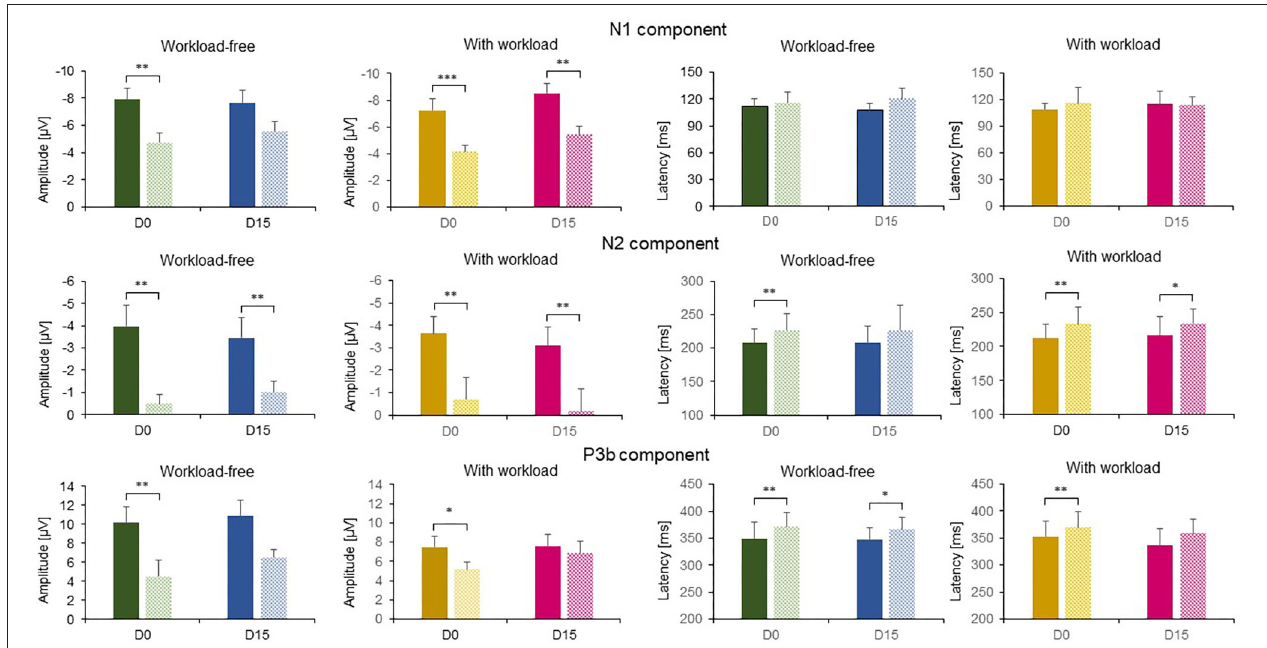
FIGURE 2 | Bar histograms represent averaged amplitude (left) and latency (right) of the ERP waveforms ± SD of controls (C, solid bars) and alcohol-dependent patients (ADP, dotted bars) at D0 (green, yellow) and D15 (blue, pink) for the workload-free and workload tasks for infrequent target auditory stimuli. Asterisks represent statistically significant differences in the linear regression model (* p < 0.05, ** p < 0.03, *** p <